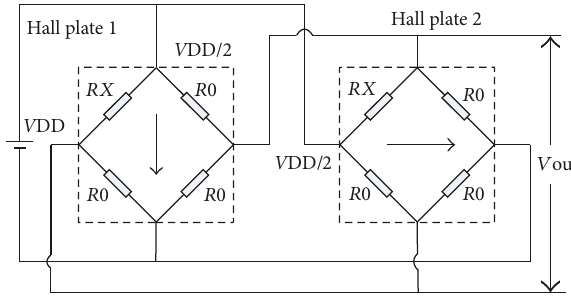
Figure 3: Orthogonal coupled Hall